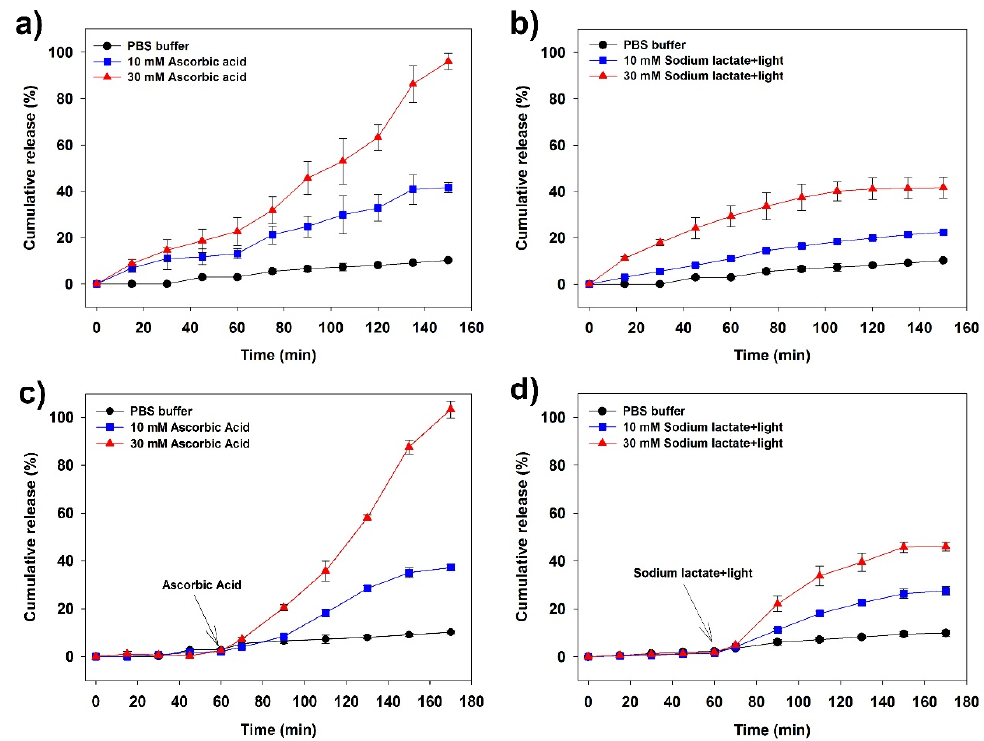
Figure 8. Congo red release percentage curves in response to ascorbic acid solution ( a ) and 405 nm visible light ( b ). In ( c ) and ( d ), release of Congo red from Fe 3 + -SG hydrogel beads during continuous exposure to a changing condition after 60 min at the presence of ascorbic acid or visible light.